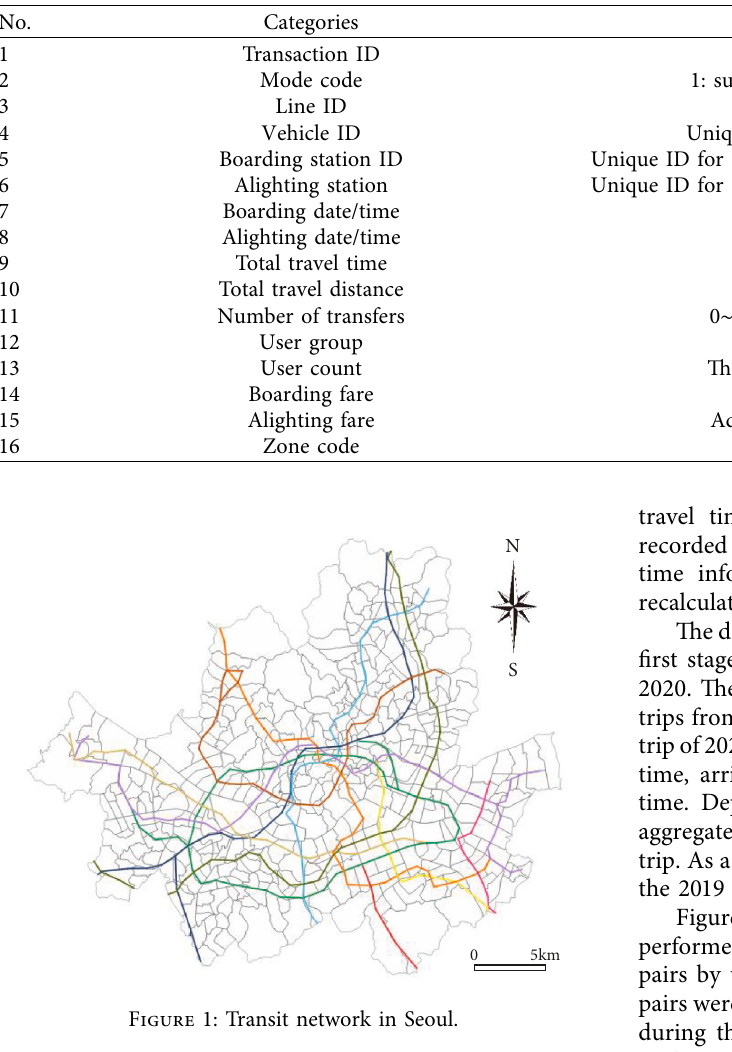
Table 1: Description of the smart card data.